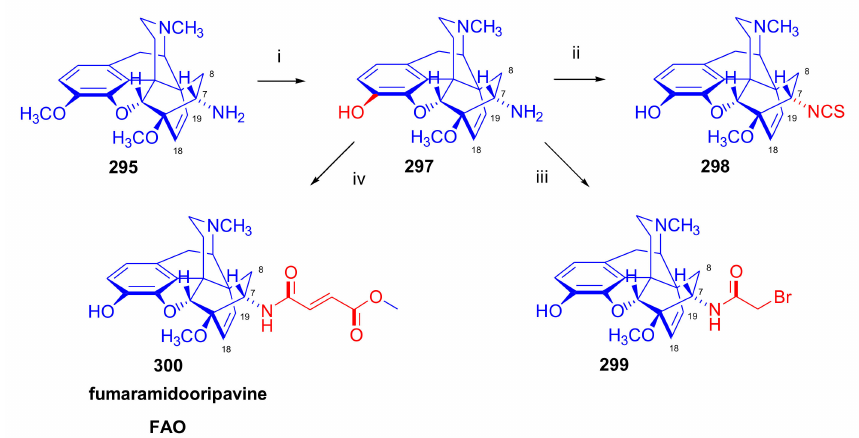
Figure 80. Synthesis of 7 α -amino-6,14-ethenomorphinan derivatives as irreversible ligands for opioid receptors. Reagents and conditions : (i): BBr 3 , CHCl 3 , 15 min, 68%; (ii): thiophosgene, NaHCO 3 , CHCl 3 , H 2 O, 15 min, 63%; (iii): bromoacetic anhydride, NaHCO 3 , CHCl 3 , H 2 O, 15 min, 61%; and (iv):